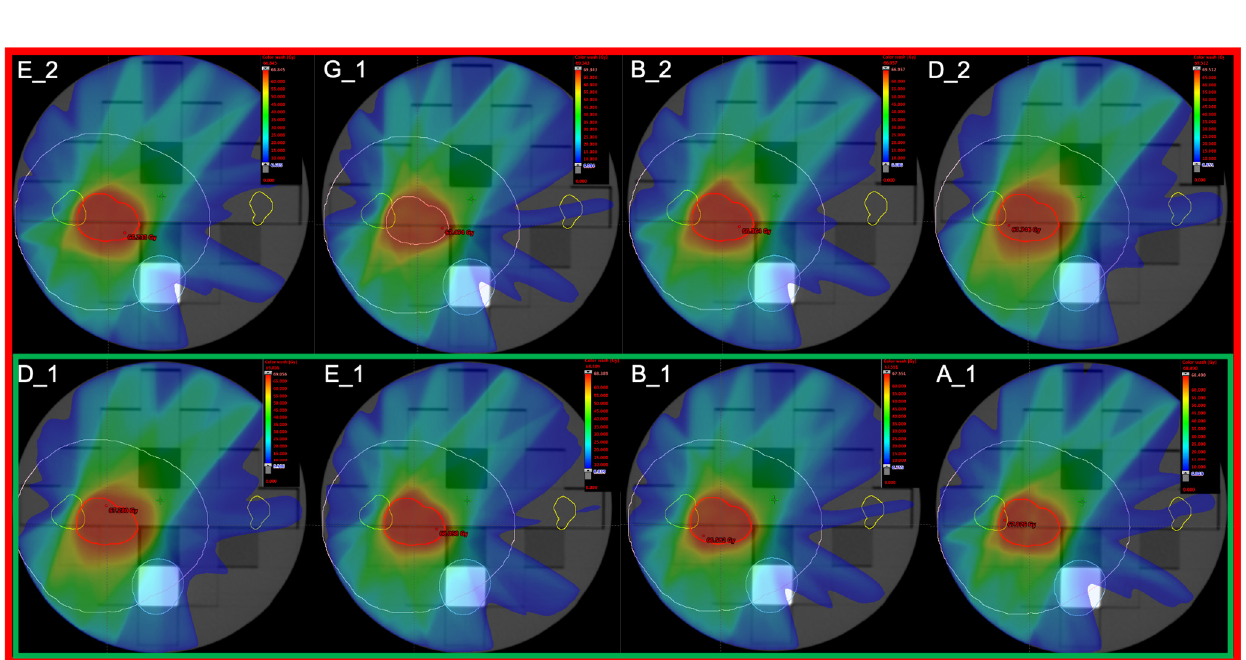
Figure 2. The four IMRT dose distributions included in the reproducibility study (within the green rectangle), and the eight IMRT dose distributions included in the stability study (within the red rectangle).